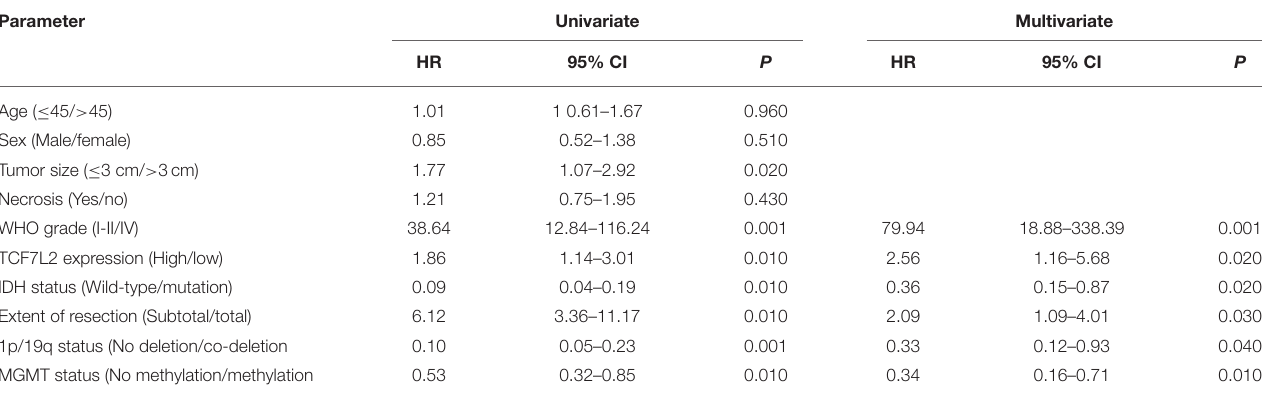
TABLE 2 | Univariate and multivariate analyses of 5-year OS. Parameter Univariate